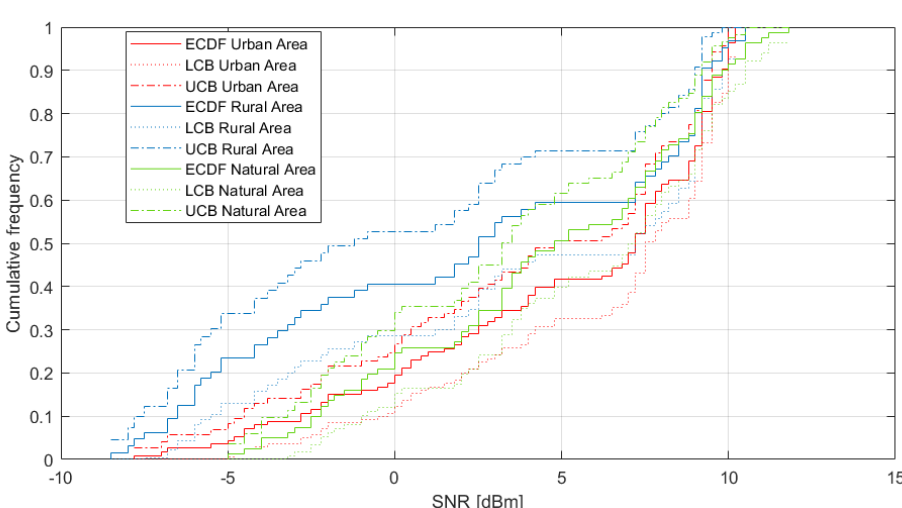
Figure 14. Empirical CDF of SNR measurements.